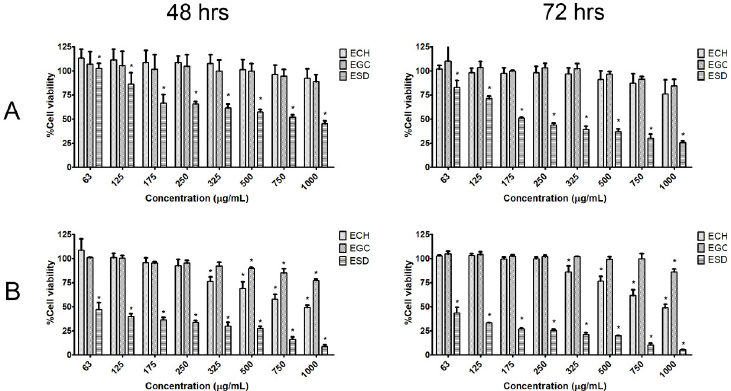
Fig 3. Percentage of CCA cell viability for (A) KKU-100 and (B) KKU-213 after treatment with each extract for 48 and 72 hrs ( � = statistical significance; p < 0.05).